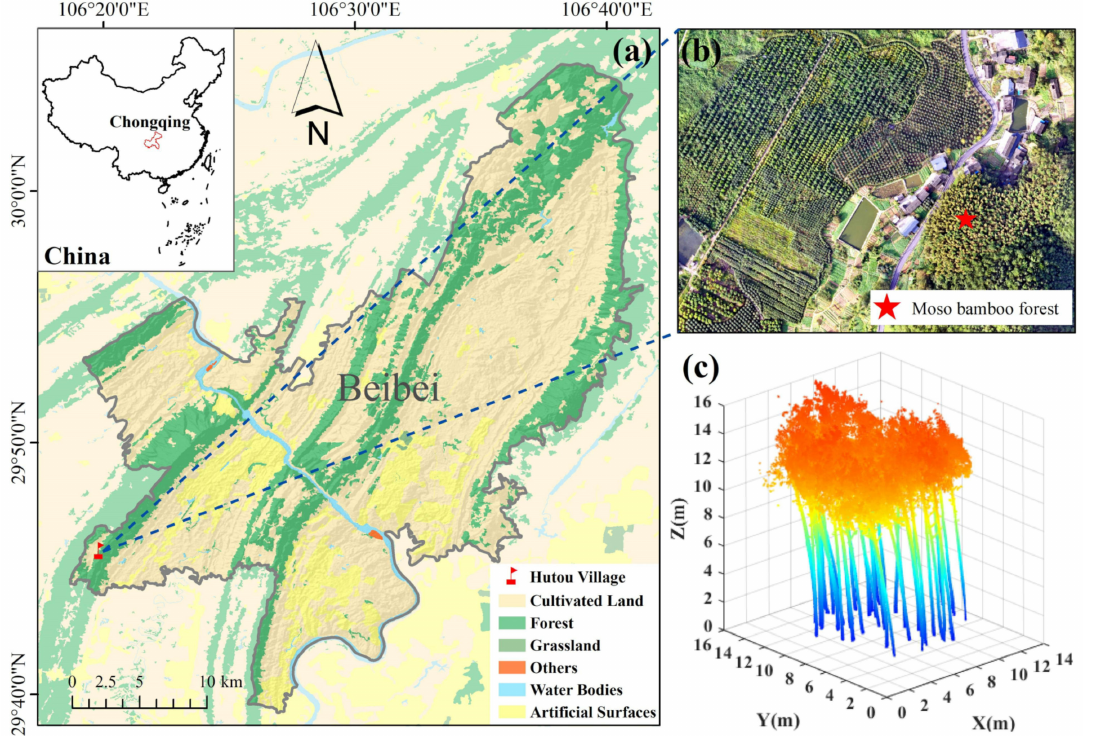
Figure 1. ( a ) The location of Hutou Village; ( b ) top view of the study site; ( c ) point cloud of sample plot after